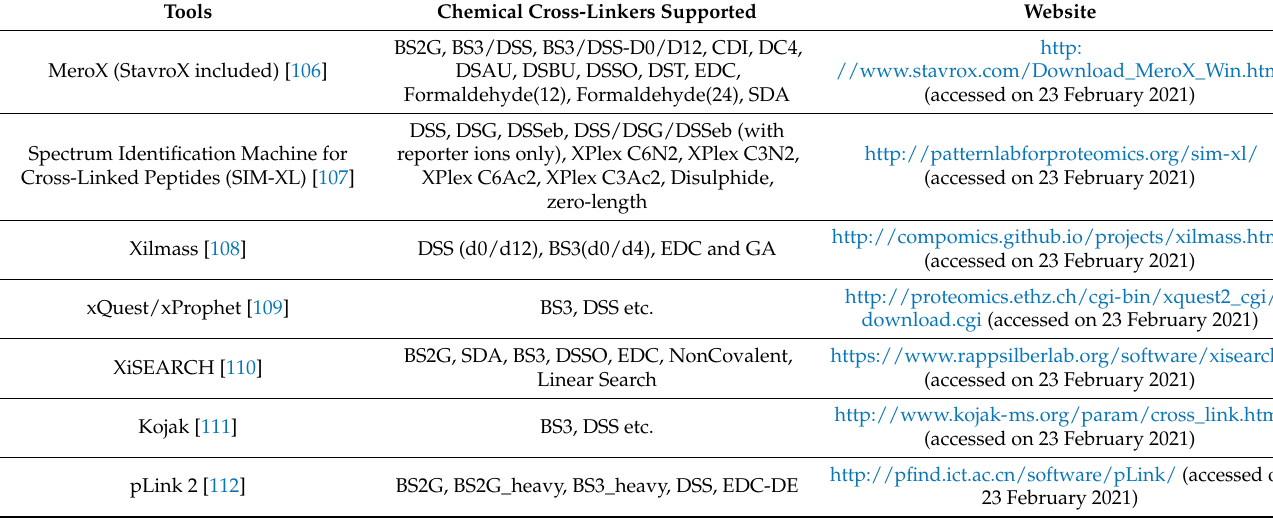
Table 1. Few examples of a diverse set of chemical cross-linkers supported by different packages or tools [105–112].